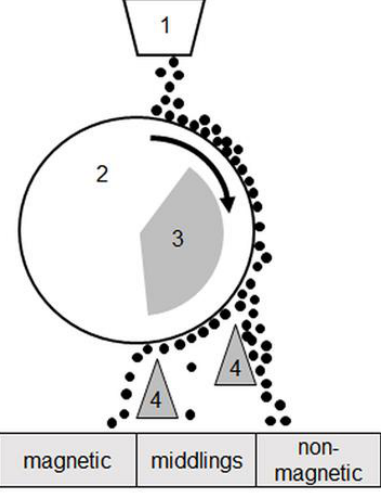
Figure 2. Rotating drum type magnetic separator (1 feeder; 2 drum; 3 permanent magnet and 4 splitter).